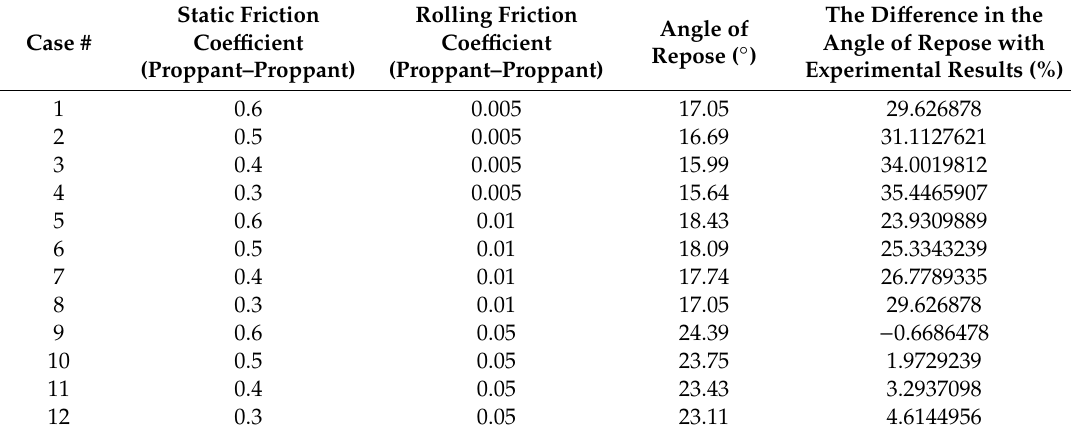
Figure 8. One simulation result of the angle of repose. Table 5. Simulation results.